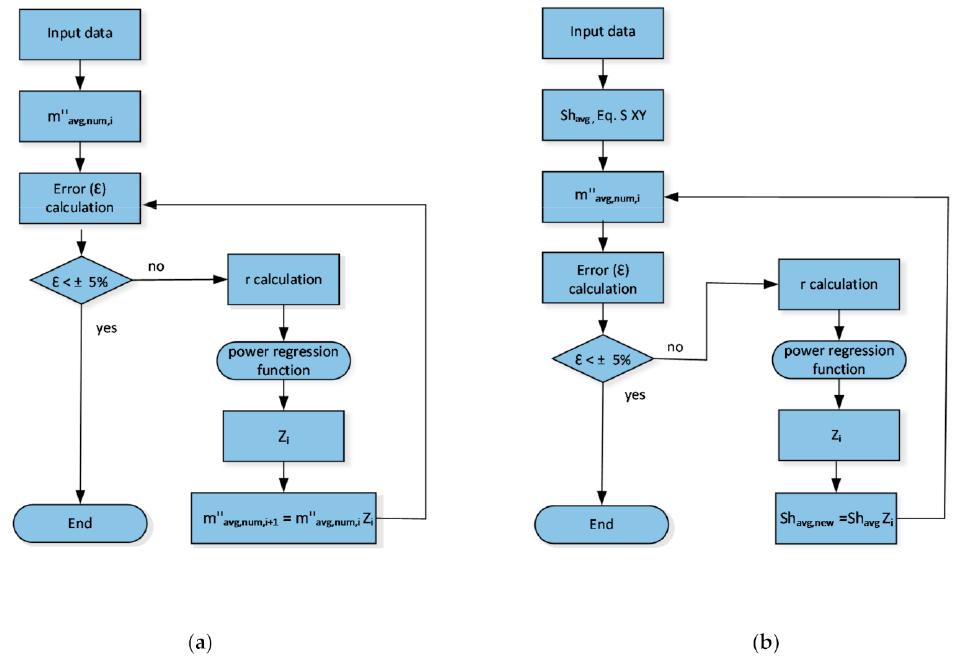
Figure 6. Calculation procedure for determining a semi-empirical correlation for the mass flux for ( a ) the vertical plates and ( b ) the horizontal